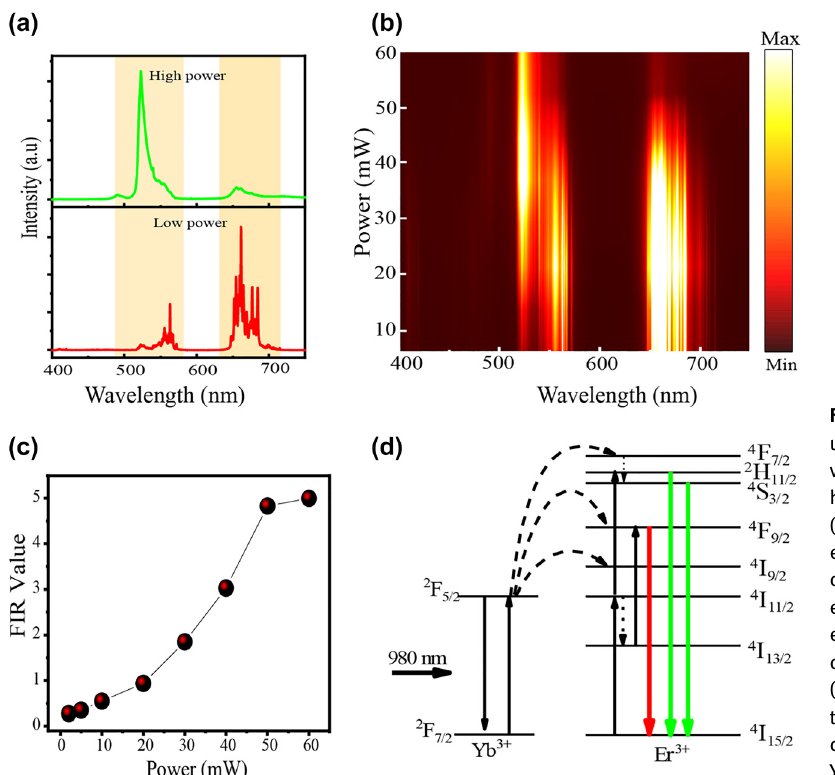
Figure 2: Power dependence of upconversion emission spectra and FIR value for the Y 2 O 3 :Er 3 + /Yb 3 + with optical